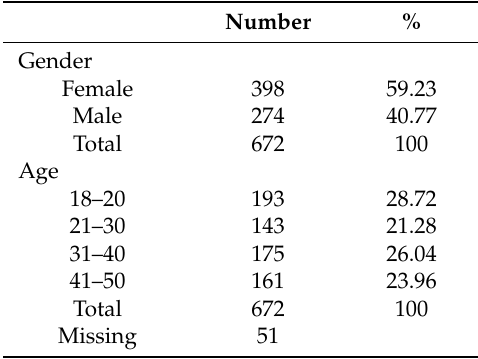
Table 2. Characteristics of the